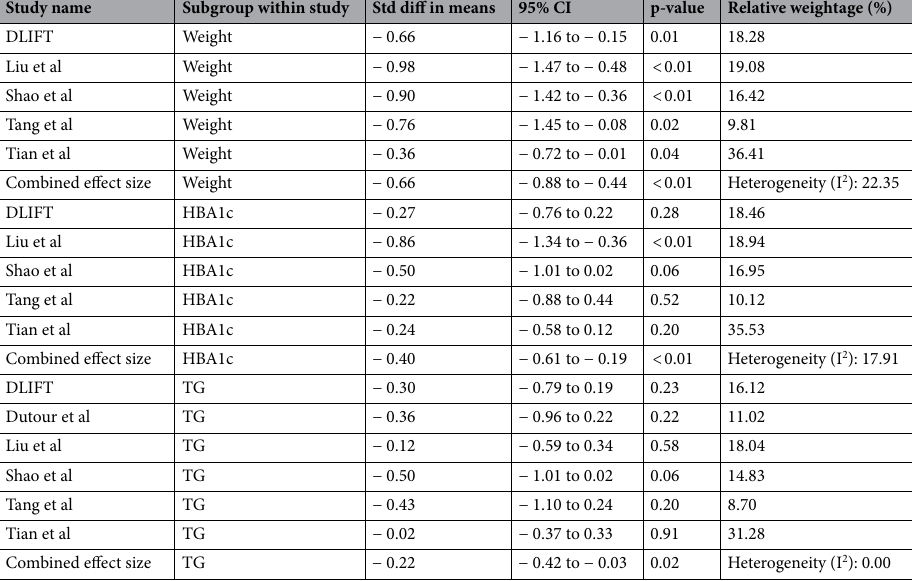
Table 4. Effect of GLP1-RA versus control on metabolic parameters: (a) Weight, (b) HBA1c, and (c) TG. CI confidence interval.